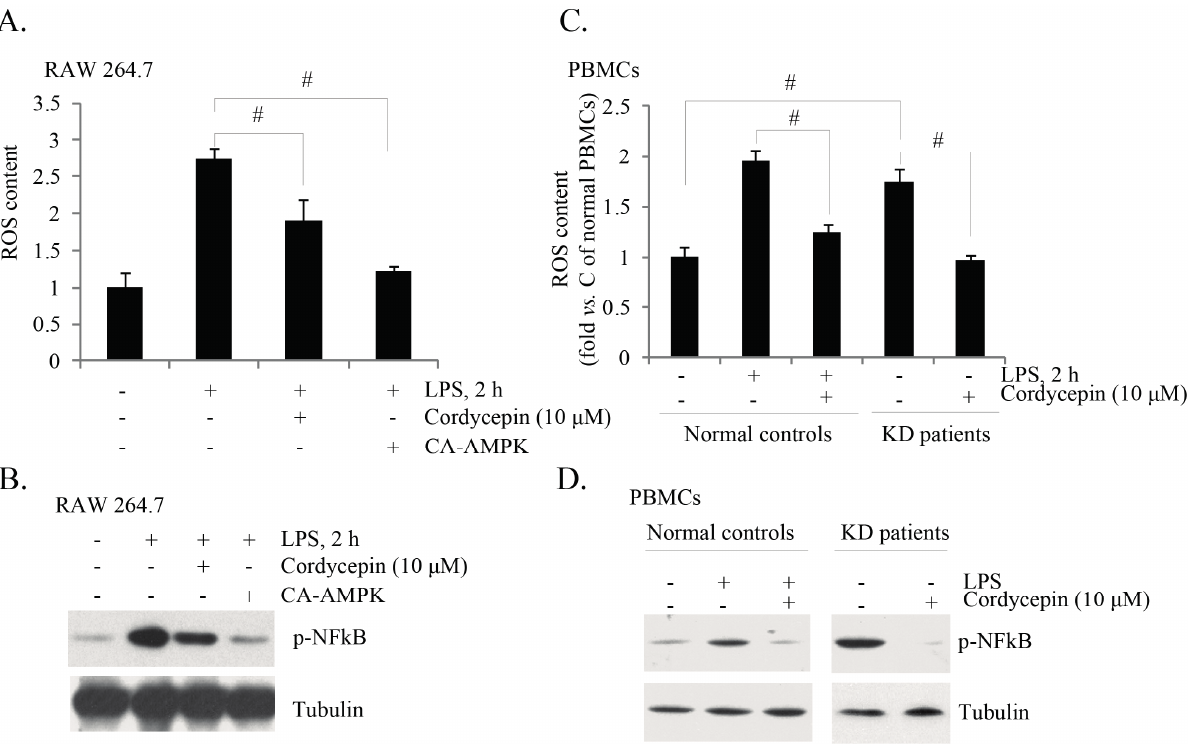
Figure 5. Cordycepin inhibits ROS (reactive oxygen species) production and NF- κ B activation in both LPS-stimulated RAW 264.7 cells and KD patients’ PBMCs. RAW 264.7 cells were pretreated with cordycepin (10 μ M, 1 h) or CA-AMPK (2 μ g/mL, 48 h), followed by LPS (1.0 μ g/mL) stimulation for 2 h, ROS production and p-NF κ B/tubulin expression were tested by FACS ( A ) and western blotting ( B ), respectively. The ex vivo cultured PBMCs of KD patients/healthy controls were treated with cordycepin (10 μ M), with or without LPS (1.0 μ g/mL) for 2 h; ROS production and p-NF κ B/tubulin expression were tested ( C , D ). The results presented were representative of three independent